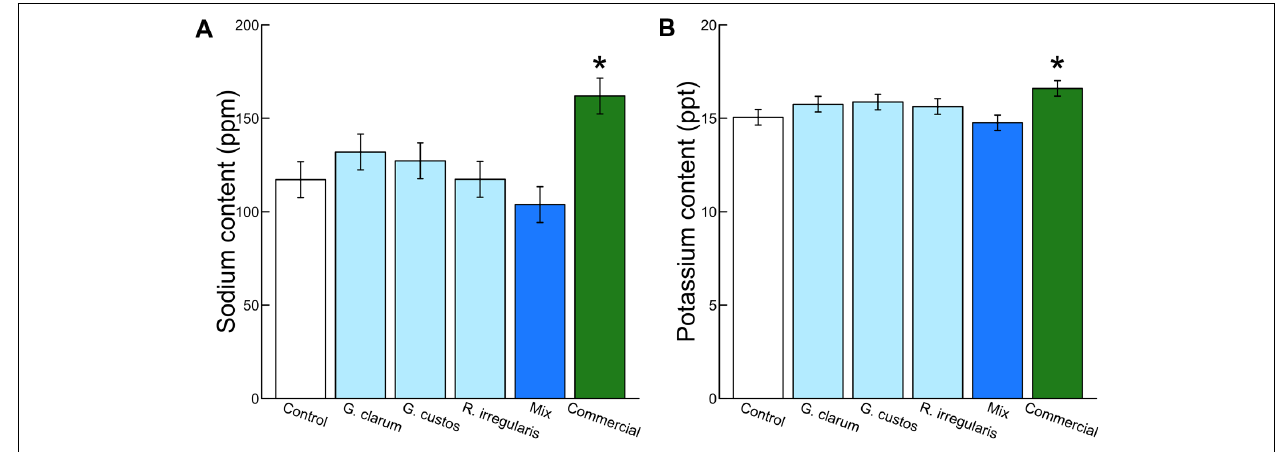
FIGURE 2 | Effects ofAMF inoculation treatments on (A) leaf Na content and (B) leaf K content. Values are fitted means expressed in parts per million ± 1 SE for Na and parts per thousand ± 1 SE for K. Asterisk indicates significant difference from non-mycorrhizal control.